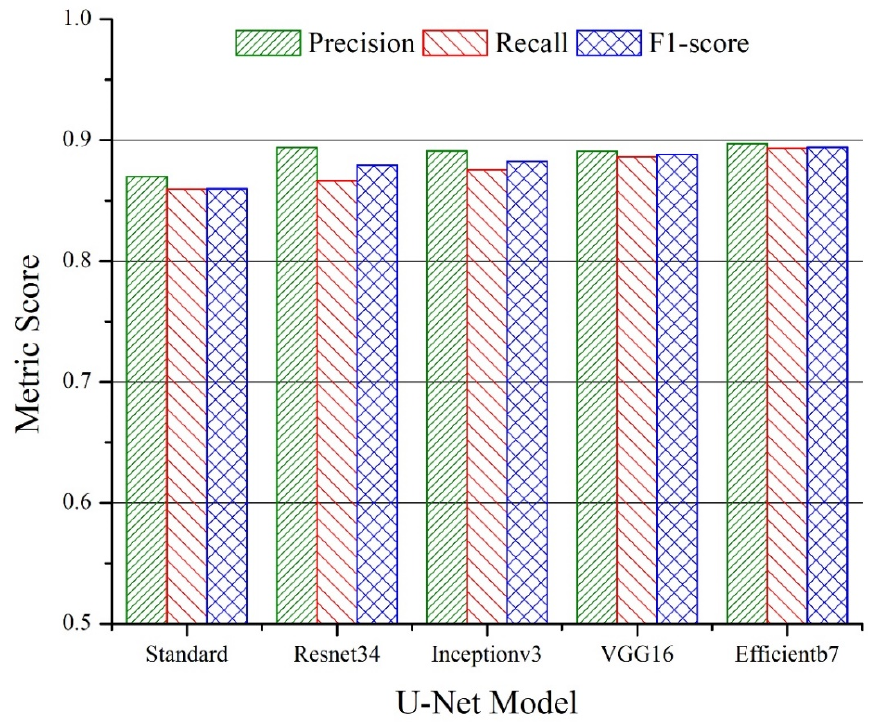
Figure 5. Average values of precision, recall and F1-score for U-Net models with different backbones for test data.